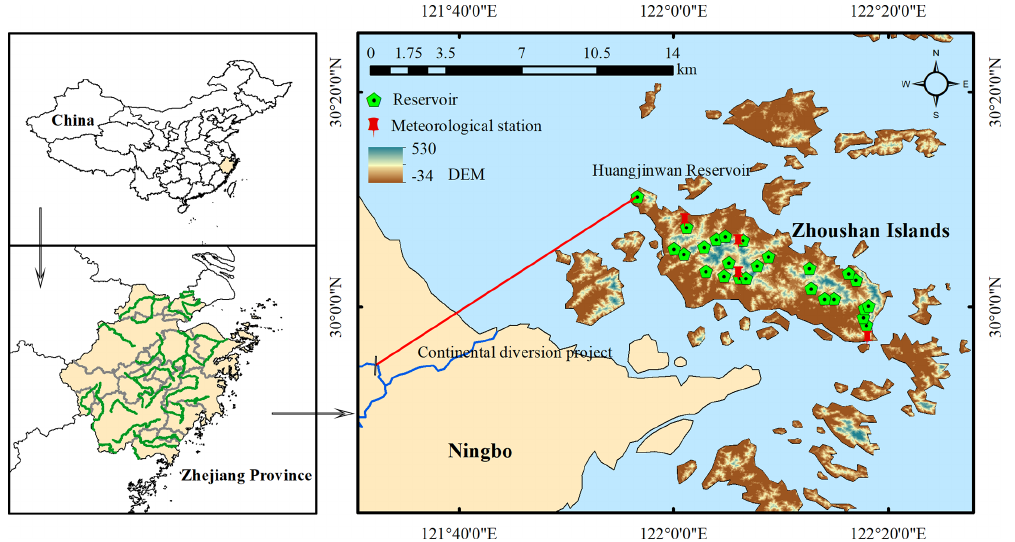
Figure 4. Location of the Zhoushan